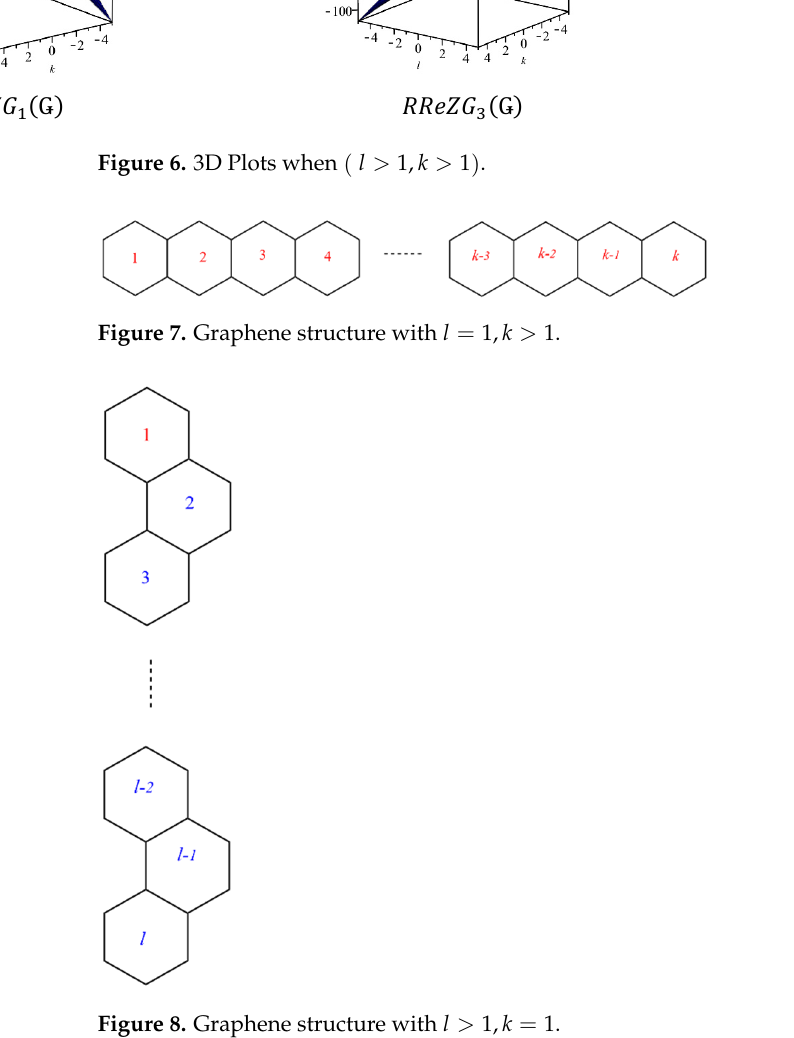
Figure 6. 3 D Plots when ( 𝑙 > 1, 𝑘 > 1) .